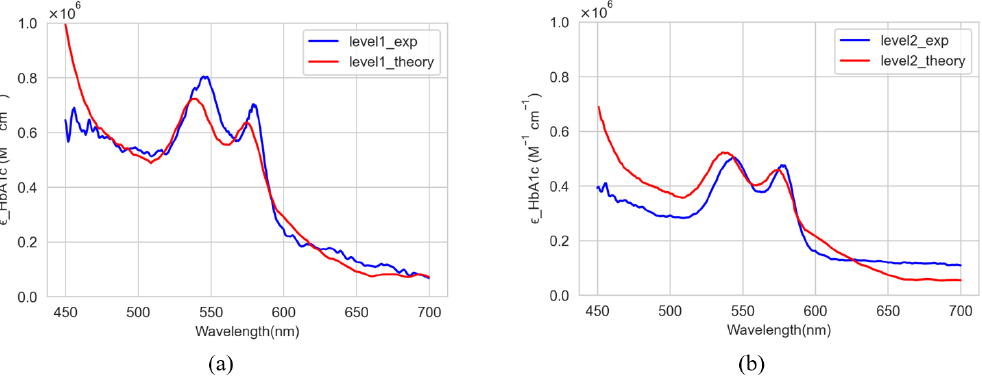
Figure 8. Experimentally calculated mean molar absorption coefficients for levels 1 and 2.